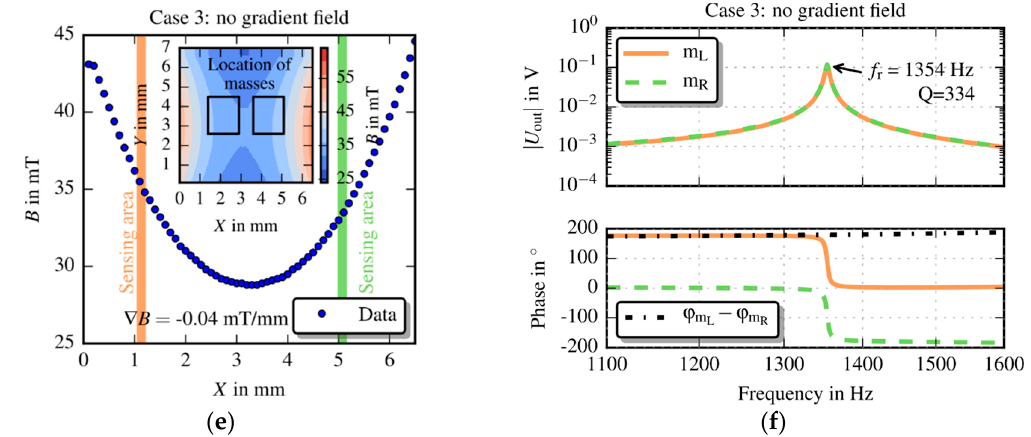
Figure 3. ( a ,c, e ) depicts the B -field distribution between the magnets characterised with a Hall probe (Teslameter FM302, AS-HAP) for different magnet configurations (insets) and position of the masses within these fields. The sensing position of the masses are located at the outermost edges and are highlighted orange and green for m L and m R , respectively. Measured transfer functions around the sensor’s resonant frequency for all three cases are shown in ( b , d , f ). The quality factor of 334 was extracted via the − 3 dB bandwidth